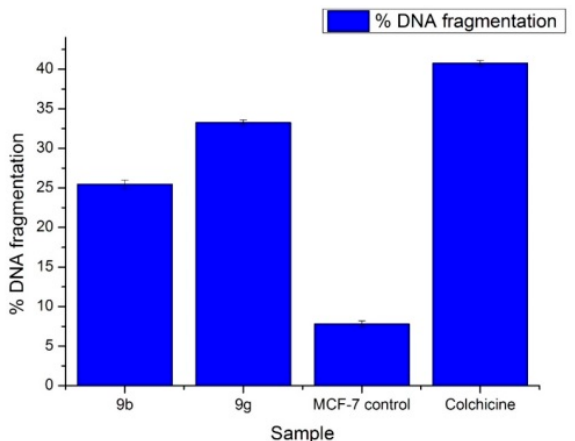
Figure 4. The percentage DNA fragmentation of treated cells with IC 50 of compound 9b (19.8 µ g / mL) and IC 50 of 9g (26.2 µ g / mL) compared to untreated control cells and cells treated with reference drug Colchicine ( p < 0.05).